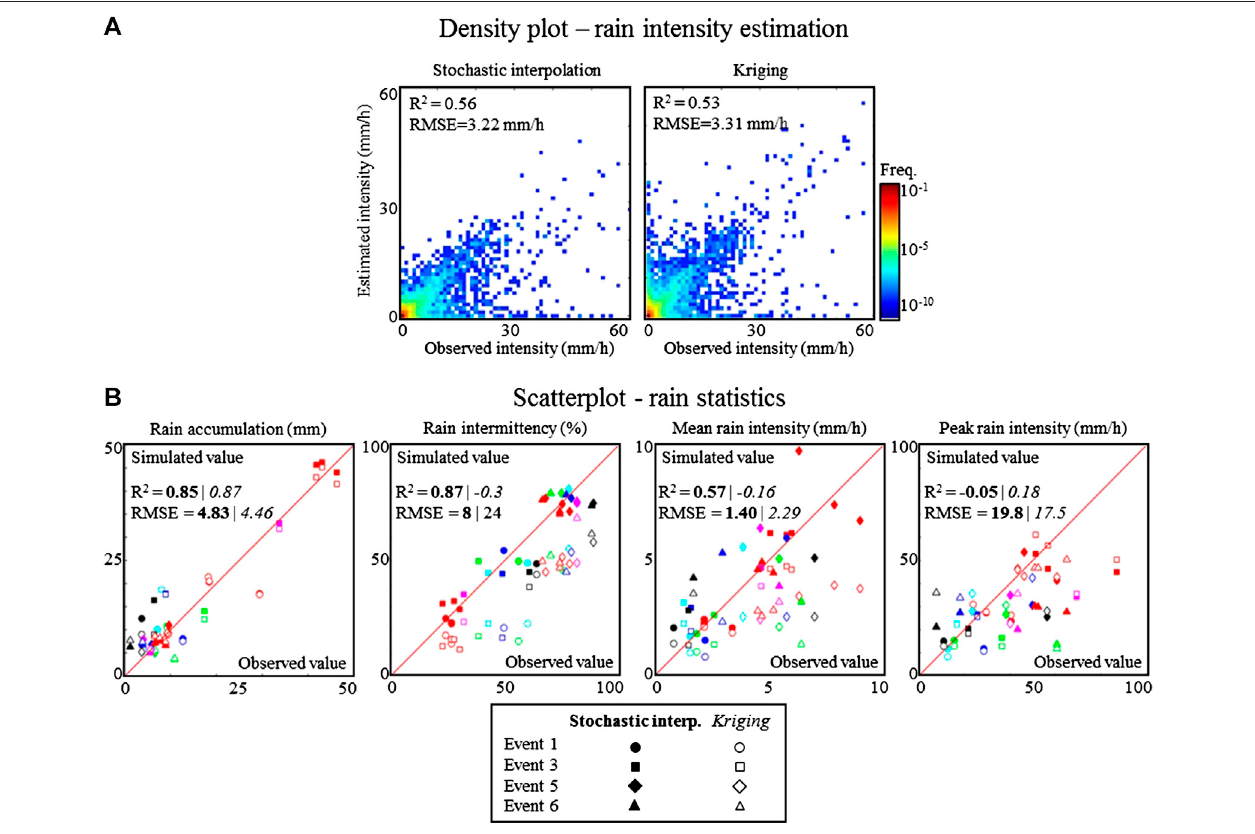
FIGURE 4 | Cross-validation results. (A) Density plot evaluating the performance of rain intensity estimation. Left panel: rain estimation derived from stochastic interpolation(the medianof50realizations isused asanestimator ofrain intensity). Rightpanel: rainestimationderivedfrom simpleKriging. (B) Scatterplots ofsimulated vs.observedrainstatistics.Thestatisticsofinterestare,fromlefttoright:rainaccumulation,rainintermittency,meanrainintensity(evaluatedoverwetintervals)andpeak rain intensity. Differentcolors refer to different rain gauges (the color code is the same as in Figure 2 ). Different symbols refer todifferent rain events. Filled symbols refer to the results of stochastic interpolation, and open symbols refer to Kriging.